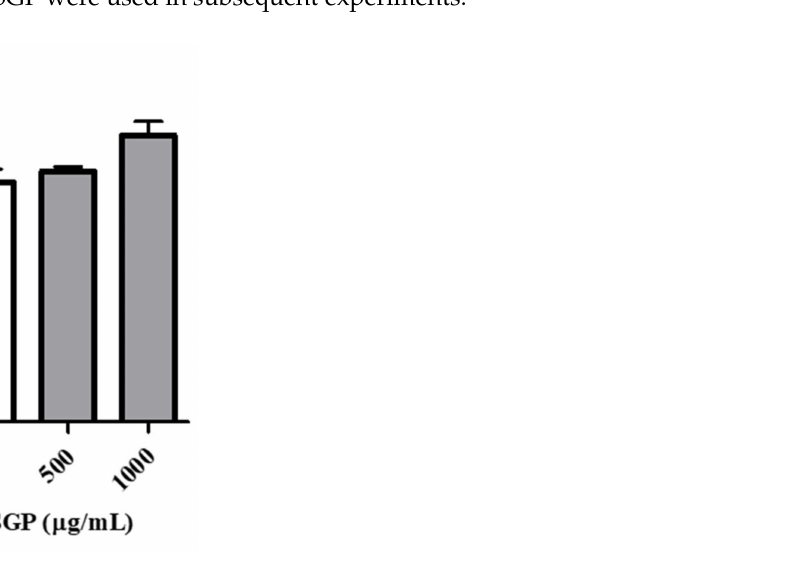
Figure 3. Effect of SGP on the proliferation of RAW264.7 macrophages. RAW264.7 cells were stimulated with indicated concentration of SGP for 22 h, and cell proliferation was evaluated an EZ-Cytox